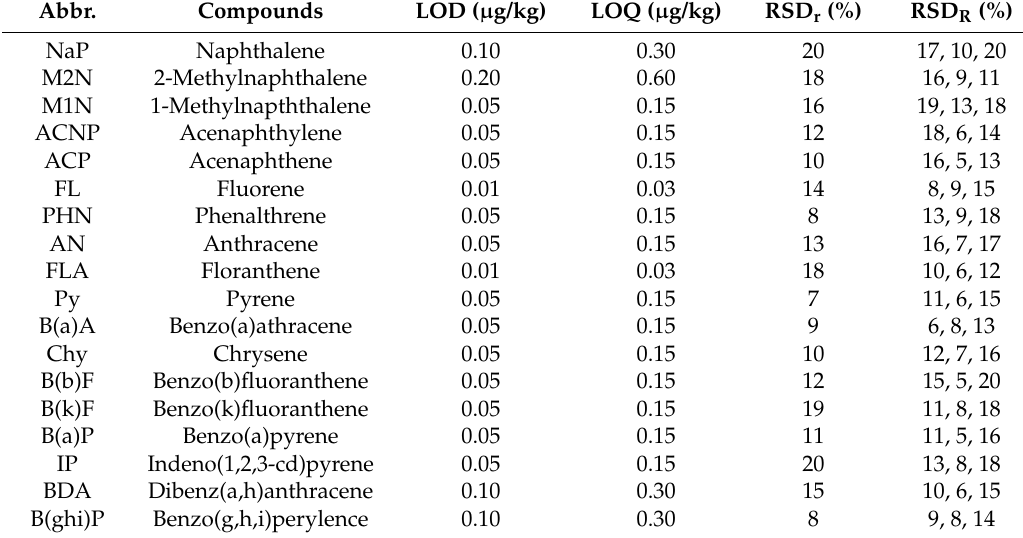
Table 3. Limit of detection (LOD; µ g/kg), limit of quantification (LOQ; µ g/kg), repeatability relative standard deviation (RSD r ; n = 8), and reproducibility relative standard deviation (RSD R ; n =